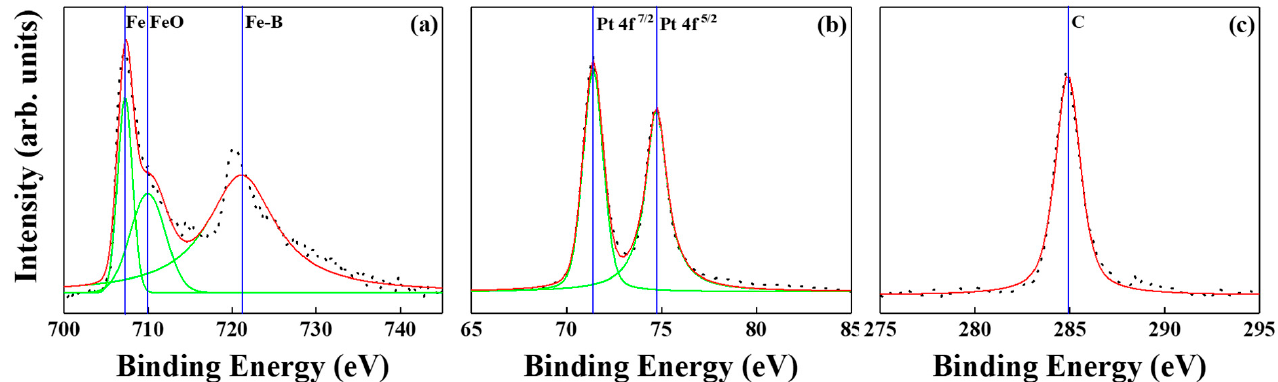
Figure 12. XPS spectra of BN/FePtCAg/MgTiON film, ( a ) the metallic Fe, iron-oxide and iron-boride are indexed, ( b ) Pt and ( c ) C.